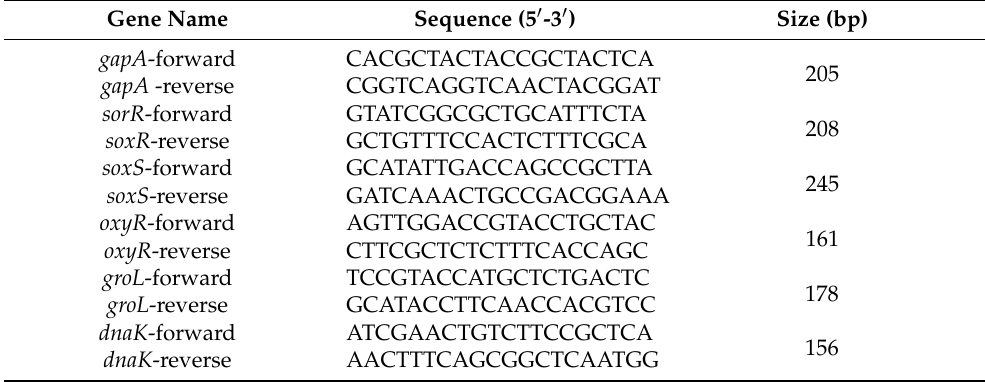
Table 2. Primer list used in the